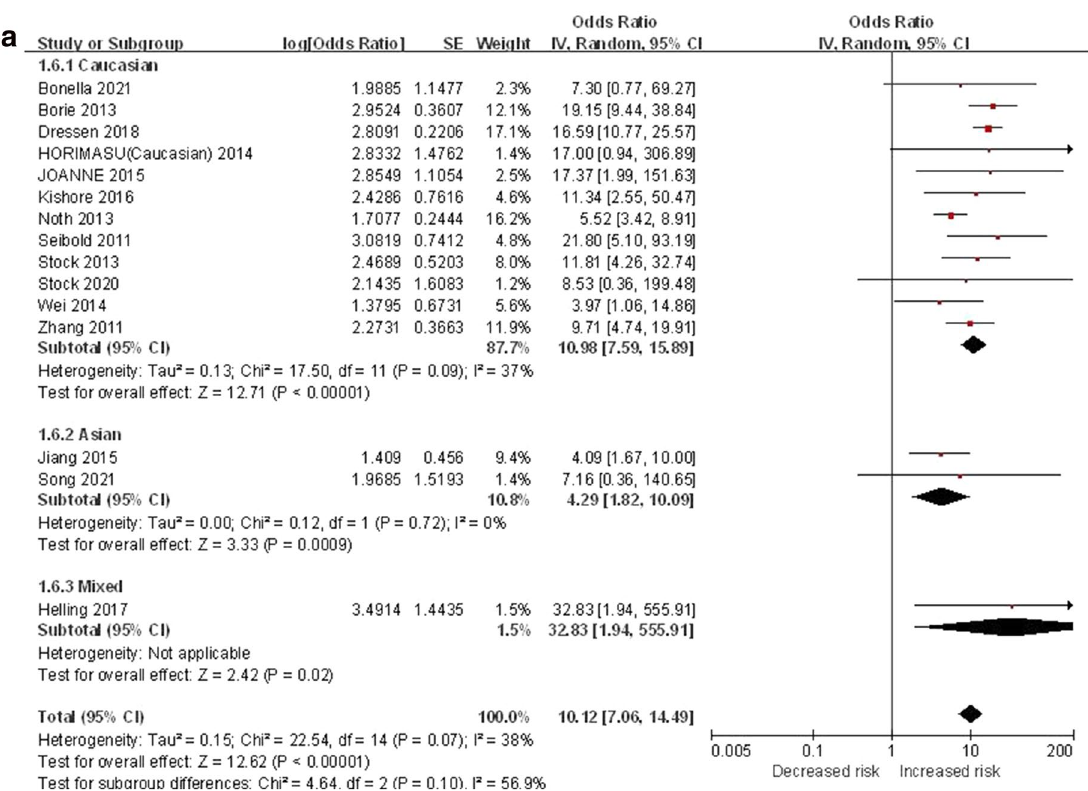
Figure 3. The TT vs. GG model was used to evaluate the correlation between MUC5B gene polymorphism and IPF susceptibility. ( a ) Forest plot of TT vs. GG genetic model. ( b ) Trial sequential analysis of MUC5B polymorphism and IPF risk using the additive genetic model (TT vs. GG) (Adjusted Boundaries Print). Although the combined sample size (N = 7690) did not exceed RIS (N = 16,994), the cumulative Z curve crossed the conventional boundary and the TSA boundary, and the association was established in advance. ( c ) Inverted funnel chart of TT vs.